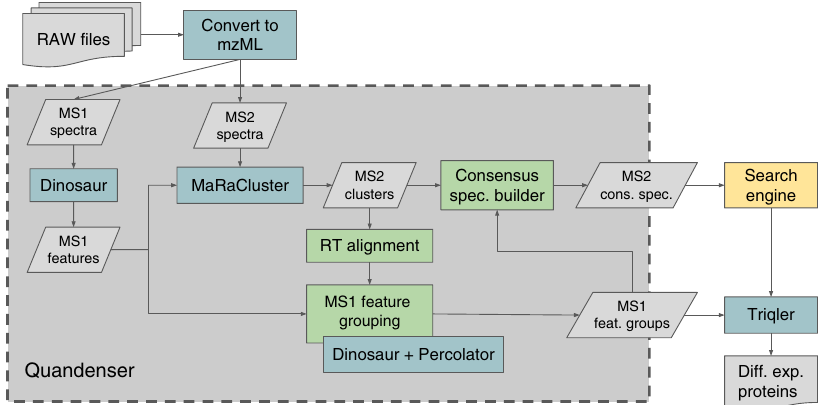
Fig. 4 Quandenser and its role in the protein quanti fi cation pipeline. Blue boxes represent existing software packages, some of which are directly integrated into the Quandenser package, green boxes represent in-house packages, gray boxes represent intermediate results or fi les, and the yellow box represents any search engine(s)